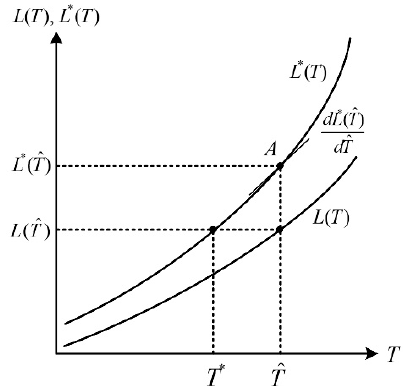
Figure 7. Exact and approximation radiance according to temperature.